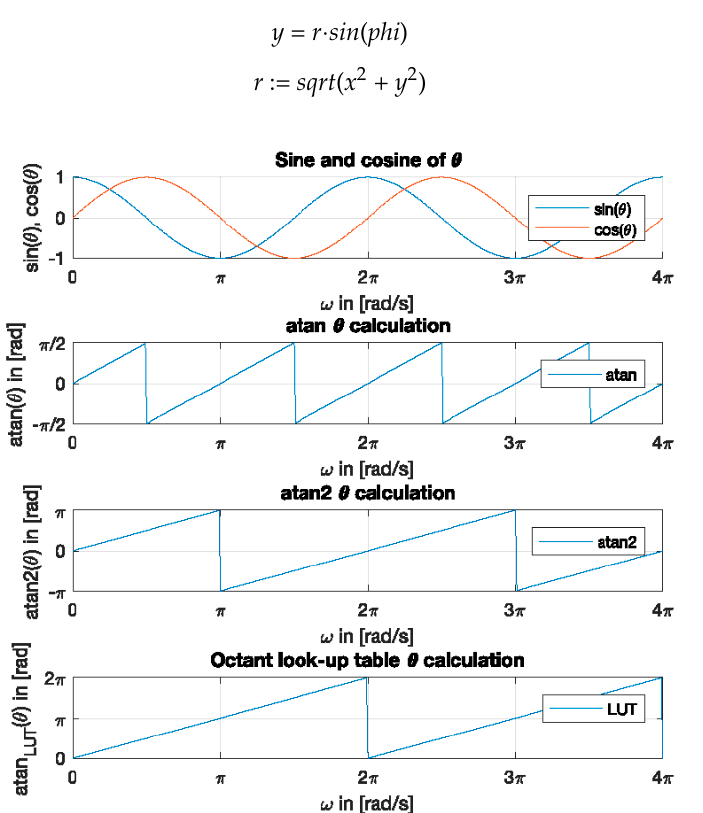
Figure 5. Position determination based on the demodulated, envelope resolver feedback signals.